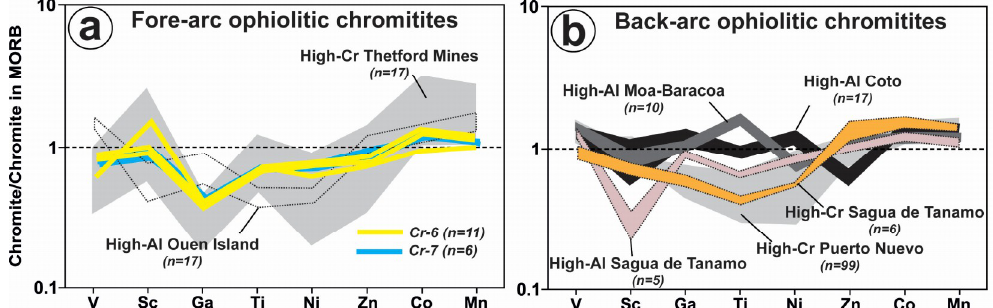
Figure 10. Spider diagrams showing the composition of minor- and trace-elements of chromites from chromitites of the two chromitite bodies analyzed in this study from the North Andaman ophiolite. Comparisons with other low-pressure chromitites from supra-subduction zone ophiolites in fore-arc and back-arc regions are shown in ( a , b ) respectively. Data sources for high-Cr chromitites of the Thetford Mine ophiolite are from [72] and those for the high-Al chromitites of Ouen Island in New Caledonia are from [73]. Data for high-Al and high-Cr chromitites from back-arc regions in ophiolites are taken from the compilation by [12].